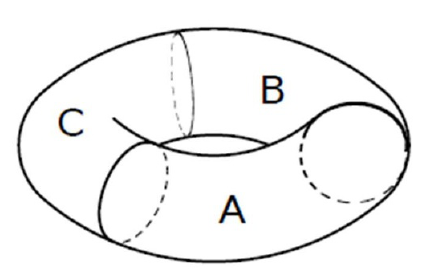
Figure 5 . The Grover-Turner-Vishwanath construction generalizes the Kitaev-Preskill scheme to three dimensions and isolates the analogue of topological entanglement entropy in Maxwell theory